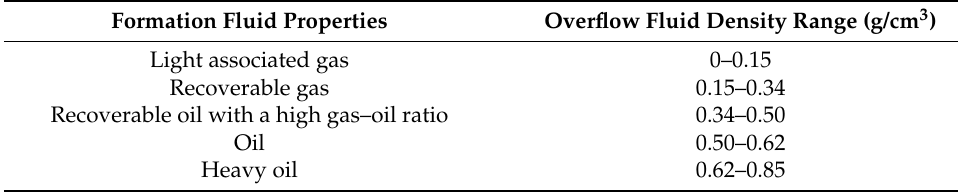
Table 4. Formation fluid properties and overflow fluid density range comparison